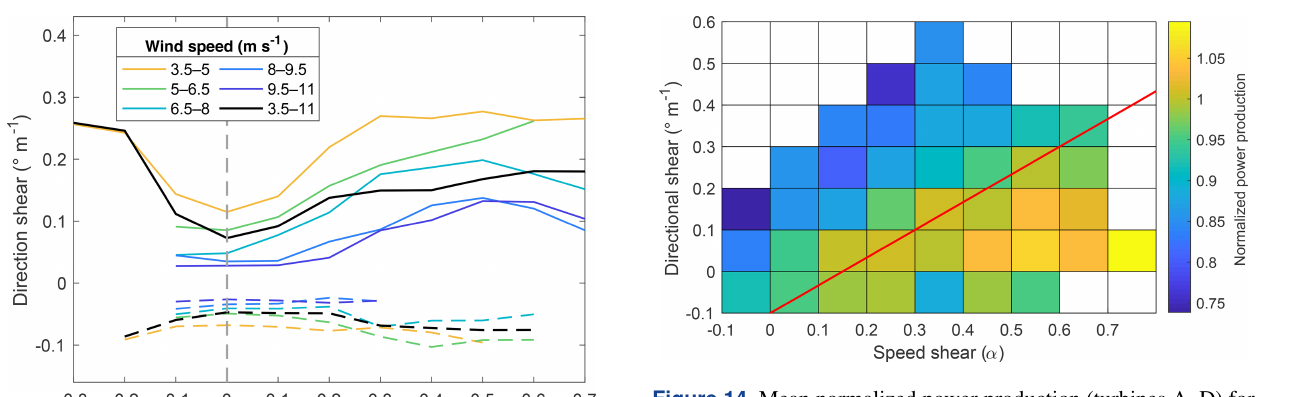
Figure 14. Mean normalized power production (turbines A–D) for all combinations of speed and direction shear that present more than 30 observations. The red line represents the α/β